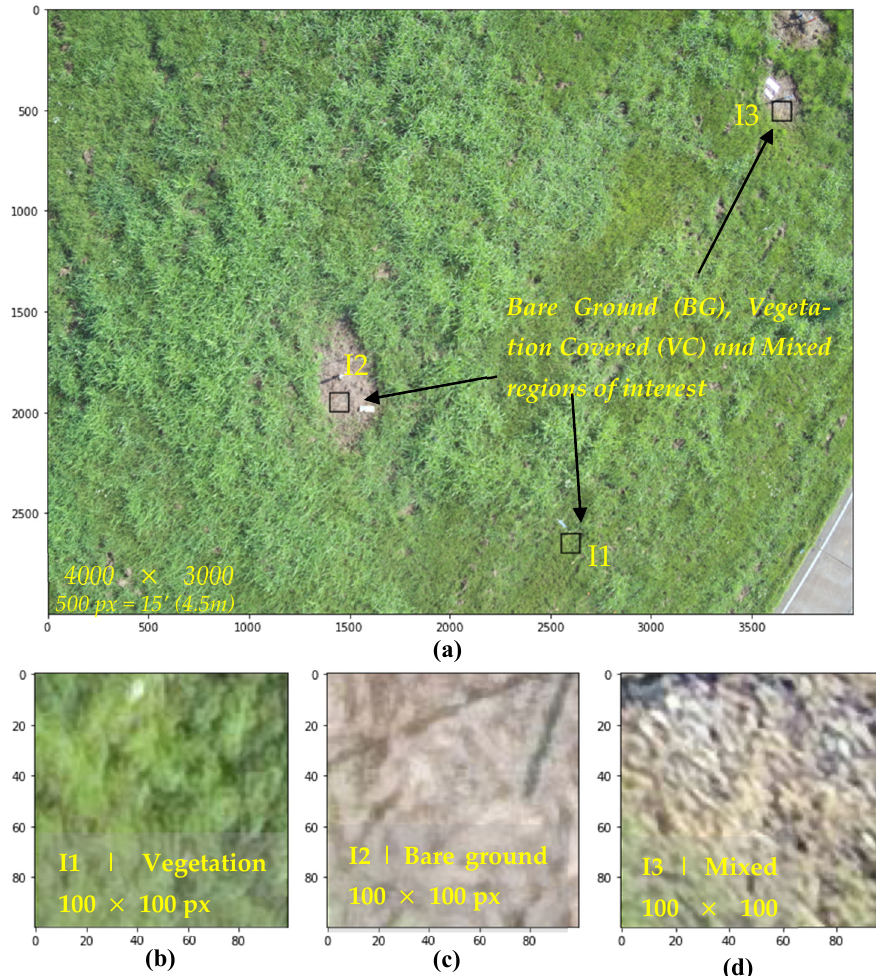
Figure 4. ( a ) Terry Road slope UAV optical image. ( b ) Region of interest 1. ( c ) Region of interest 2. ( d ) Region of interest 3.